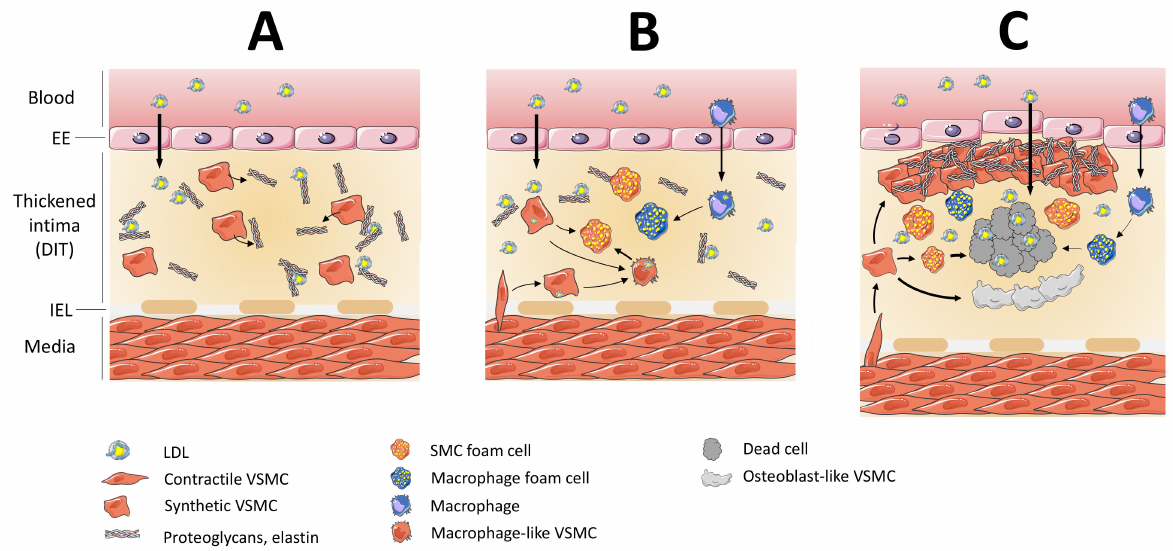
Figure 3. Role of VSMCs in atherosclerosis. ( A ) Pre-atherosclerosis: An excess of circulating LDL particles favors their passage into the sub-endothelial space where they undergo oxidation mediated by surrounding cells and enhanced by the presence of extracellular matrix compounds. This diffuse intimal thickening contains synthetic VSMCs and their secretory products elastin and proteoglycans. VSMCs may also express scavenger receptors, allowing them to ingest oxidized LDLs in a non-regulated fashion and leading to the formation and accumulation of foam cells. ( B ) Macrophage infiltration, VSMC migration and foam cell formation: Monocytes enter the arterial wall and differentiate into macrophages, whereas medial VSMC migrate the intima, where they accumulate LDL particles and become foam cells. ( C ) Fibrous cap and necrotic core formation and calcification: Synthetic VSMCs are responsible for the formation of the fibrous cap, which prevents plaque rupture. However, apoptotic VSMCs also participate in the formation of a necrotic core. Finally, VSMCs may adopt an osteoblast-like cell phenotype, resulting in plaque calcification. EE: Endothelial cells; DIT: Diffuse Intimal Thickening; IEL: Internal elastic